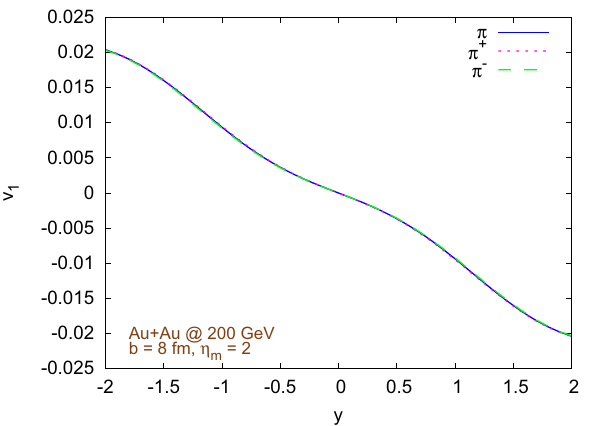
Fig. 11 In this figure we evaluate the effects of a charge dependent freezeout (see App. H) on the directed flow of pions. Left: v 1 ( y ) for pionsneglectingtheirelectricchargeandforpositiveandnegativepions. Right: difference between v 1 ( y ) of positive and negative pions ( × 10 3 ),